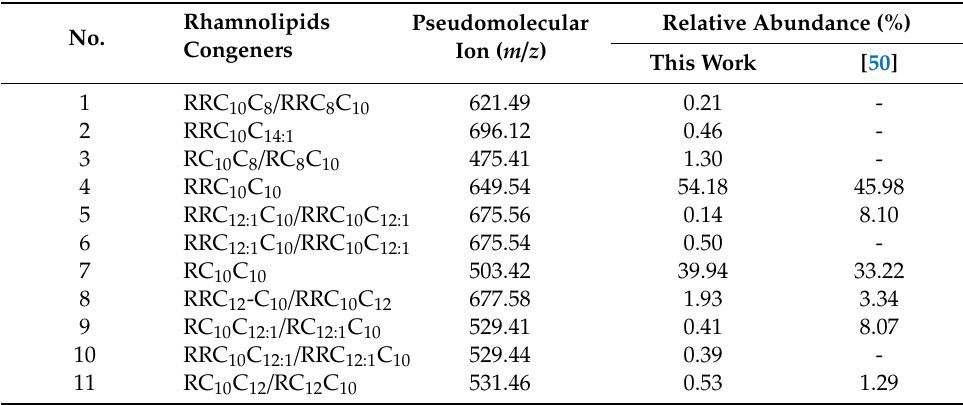
Table 5. Rhamnolipid congeners detected by HPLC-MS in crude biosurfactant produced. Rhamnolipids Pseudomolecular No. Congeners Ion ( m / z